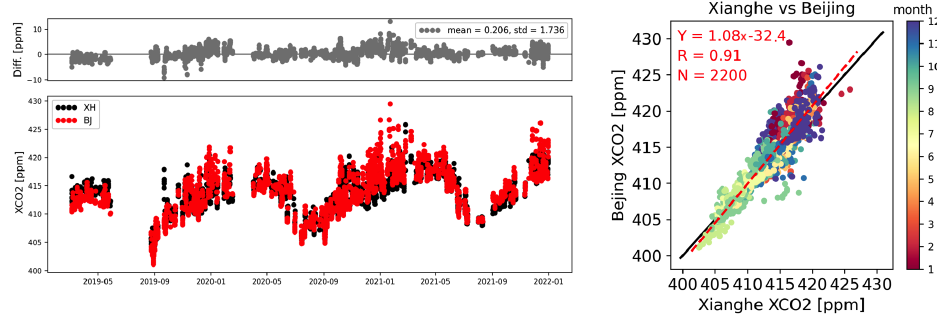
Figure 5. Left panels : the time series of the co-located EM27/SUN SN095 XCO 2 hourly means in Beijing (red) and 125 HR XCO 2 hourly means in Xianghe (black), together with their absolute difference (BJ–XH). Right panel : the scatter plots of the co-located EM27/SUN SN095 and 125 HR XCO 2 hourly means. The red dashed line is the linear fitting ( y = ax ). R is the Pearson correlation coefficient. N is the number of co-located data. The dots are coloured with the measurement